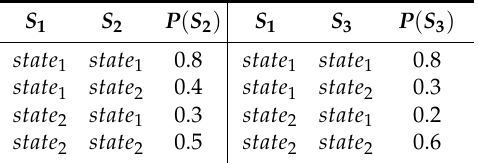
Table 4. The conditional probability table of sensor S 2 and S 3